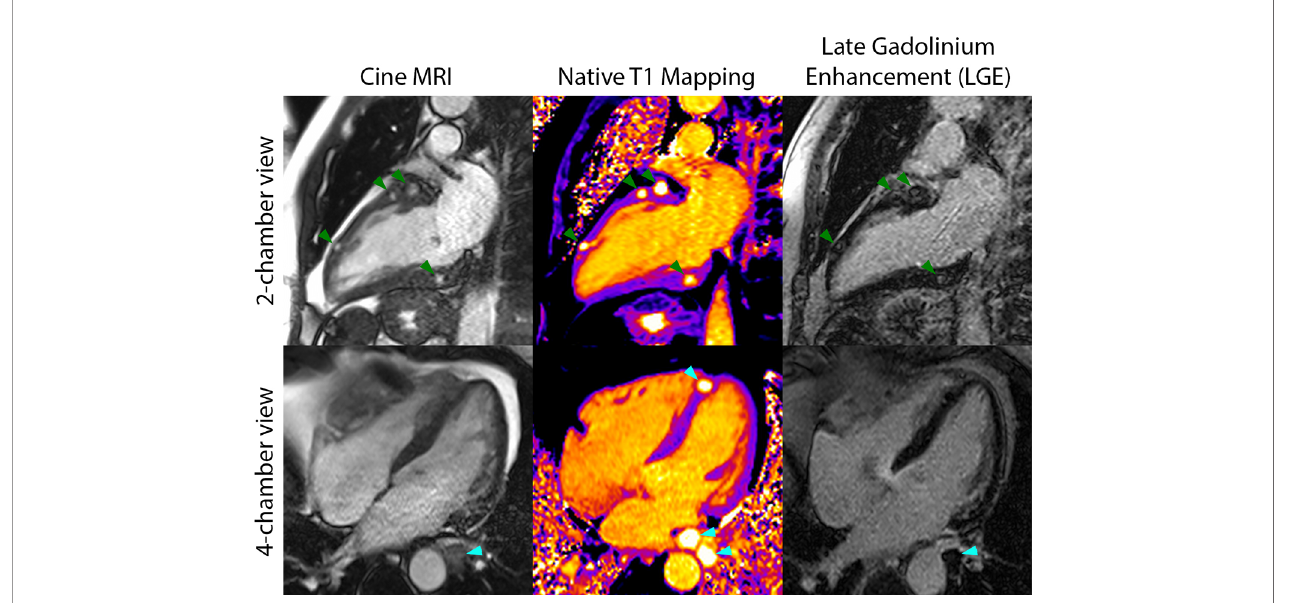
FIGURE 1 | Cardiac magnetic resonance imaging included cine MRI (left column), native T1 mapping (middle column), and late gadolinium enhancement (LGE) imaging (right column) and demonstrated several myocardial metastases on the two-chamber views (green arrows) and three metastases in the four-chamber views (cyan arrows). The metastases were best seen on T1 mapping and cine MRI and had long T1 and T2 (not shown) relative to myocardium.